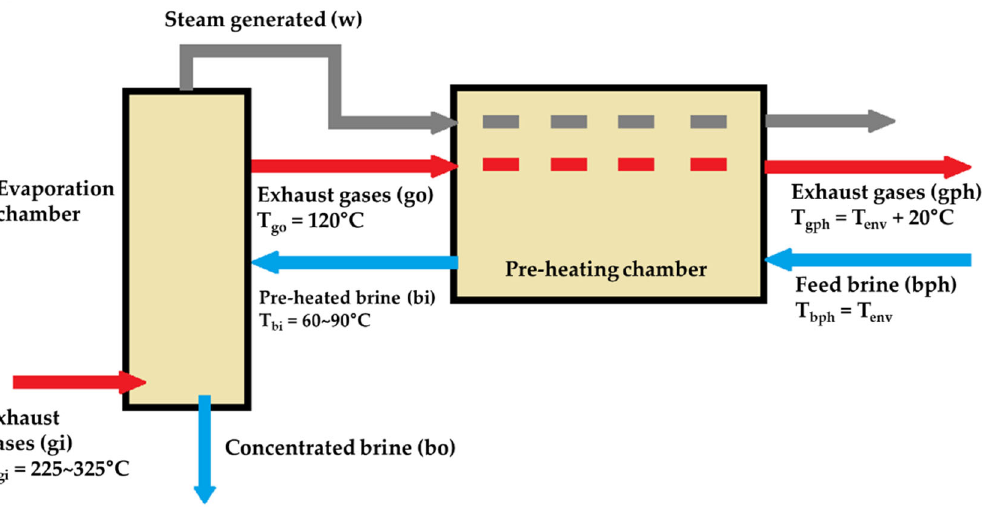
Figure 5. Conceptual diagram of the concentrate treatment system—i.e., the ZLD system if 90% of brine evaporation is achieved.